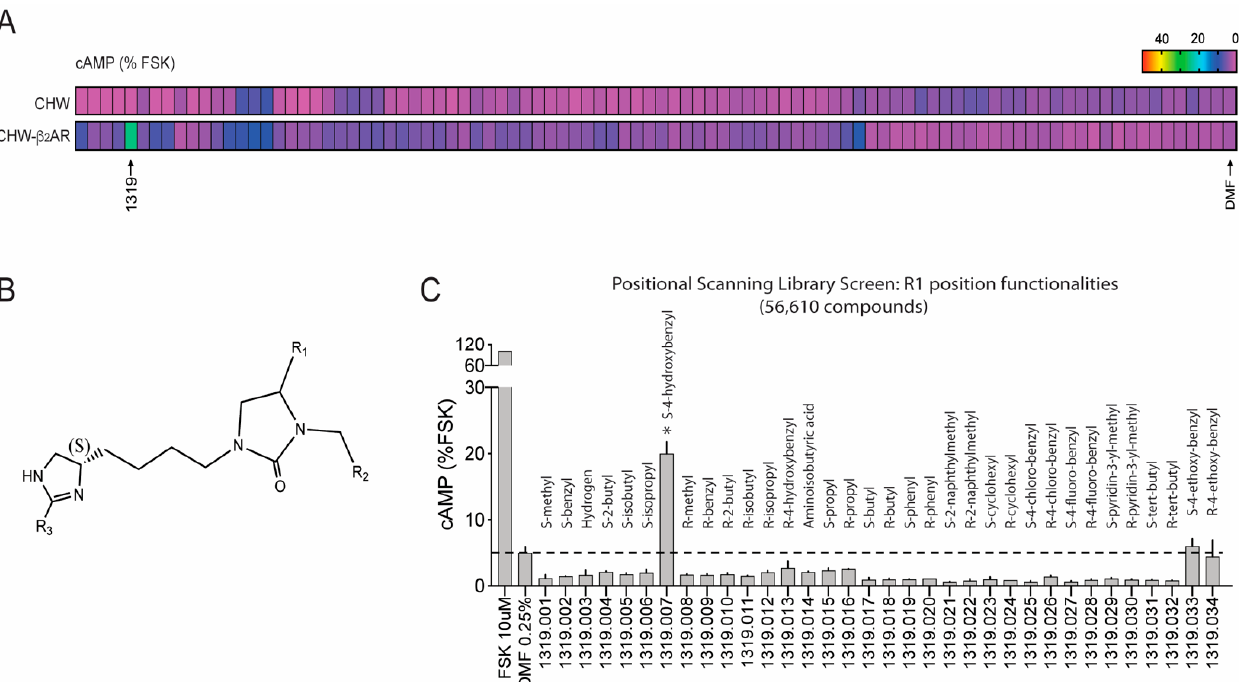
Figure 2. Discovery of novel β 2 AR agonists using scaffold ranking (SR) and positional scanning (PS) libraries. ( A ) The SR library consisting of samples of mixtures of chemicals was used to detect potential agonist acting at the β 2 AR. CHW cells stably transfected to express the human β 2 AR or non-transfected null cells (see text) were treated with an aliquot from each sample well and cAMP measured. cAMP values were normalized to the cAMP stimulated by the direct adenylyl cyclase activator forskolin. Results are shown as a heat map with the scale as indicated. PS library well #1319 stimulated cAMP in the β 2 AR-expressing cells to an extent greater than any other sample well. ( B ) The scaffold of well #1319 showing the positions of the three R-groups where substitutions were made. ( C ) Results from a portion of the PS library screen, where R 1 was changed as indicated, with all other possibilities for R 2 and R 3 . Each sample well contained 1,665 compounds. The S -4-hydroxybenzyl substitution at position R 1 resulted in activity of this mixture. *, p < 0.01 vs vehicle (0.25% dimethylformamide [DMF])